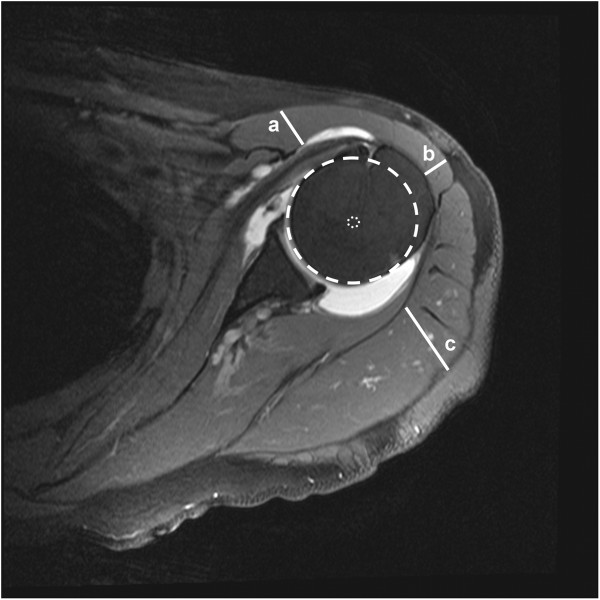
Thickness of deltoid muscle. The thickness of the ventral (a), lateral (b) and dorsal (c) portion of the deltoid muscle was measured in designated directions from the center of humeral head (center of rotation) perpendicularly or parallel to the glenoid surface.